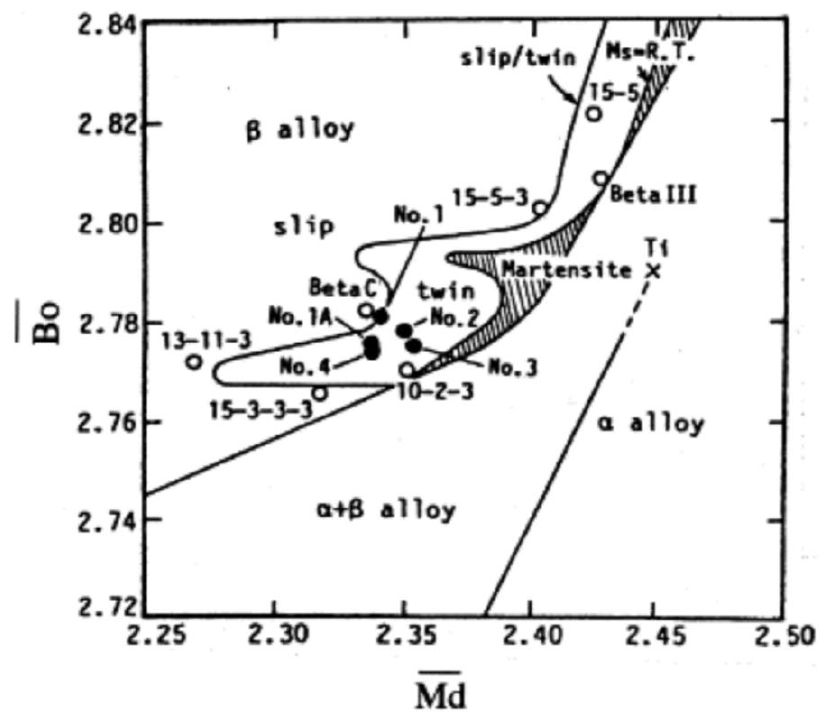
Figure 16. Phase-stability diagram for metastable and near-beta Ti alloys based on the mean d -orbital energy level, M d , and the mean bond order, B o [12] (Reprinted with permission from Materials Science and Engineering A, vol. A243, D. Kuroda et al., Design and mechanical properties of new β type titanium alloys for implant materials, 244–249, 1998).